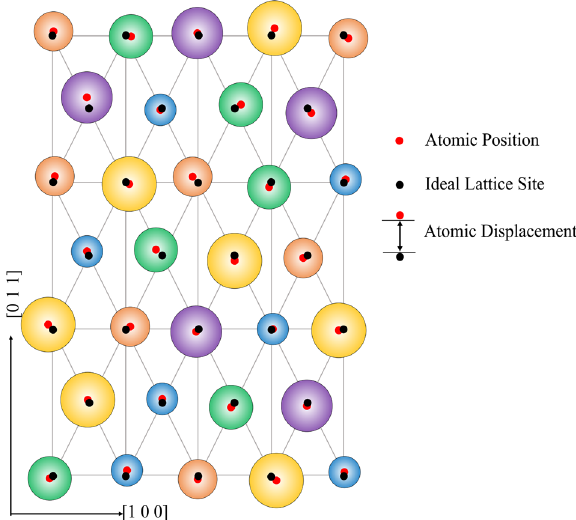
Fig. 1 A schematic shows the local atomic displacements due to lattice distortion. The red dots stand for the equilibrium atomic positions in a bcc solid-solution alloy with lattice distortion, while the black dots stand for the ideal positions in an undistorted lattice. The schematic corresponds to a projection view along the 011 direction. The big solid circles in different colors represent individual types of atoms in the